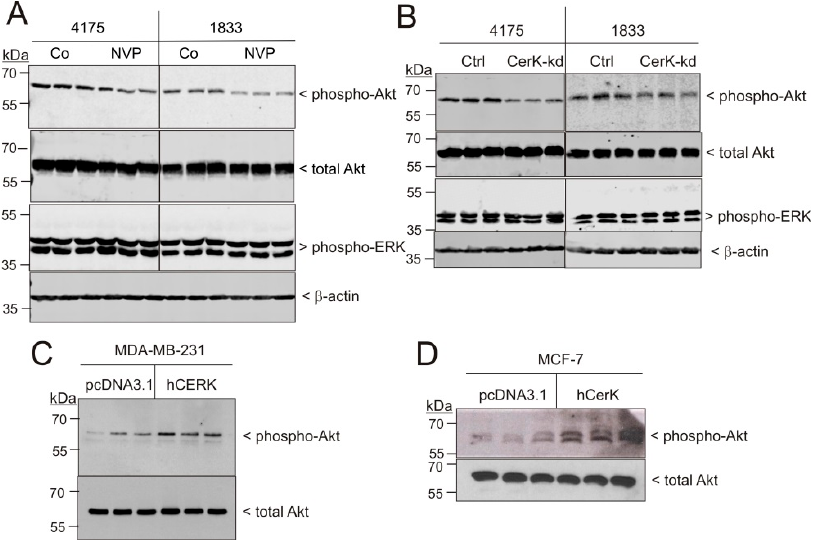
Figure 7. Effect of CerK inhibition, downregulation, and overexpression on phosphorylation of Akt in MDA-MB-231 and MCF-7 cells. ( A ) Confluent 4175 and 1833 cells were incubated for 24 h with either vehicle (Co) or NVP-231 (NVP, 1 μ M). ( B ) Then, 4175 and 1833 cells transduced with either a control vector (Ctrl) or a CerK shRNA construct (CerK-kd) were incubated for 24 h in serum-free DMEM. ( C , D ) Parental MDA-MB-231 cells ( C ) and MCF-7 cells ( D ) were transiently transfected with an empty vector (pcDNA3.1) or a vector containing the human CerK cDNA (hCerK) for overexpression. Confluent cells were incubated for 20 h in serum-free DMEM. Thereafter, protein lysates were homogenized and separated by SDS-PAGE, transferred to nitrocellulose, and subjected to Western blotting using antibodies against phospho-Ser 473 -Akt, total Akt, phospho-ERK1/2, and β -actin. Results show triplicates of one representative experiment from at least three independent determinations. Bands corresponding to phospho-Akt and total Akt were densitometrically evaluated and are depicted in supplementary Figure S9.